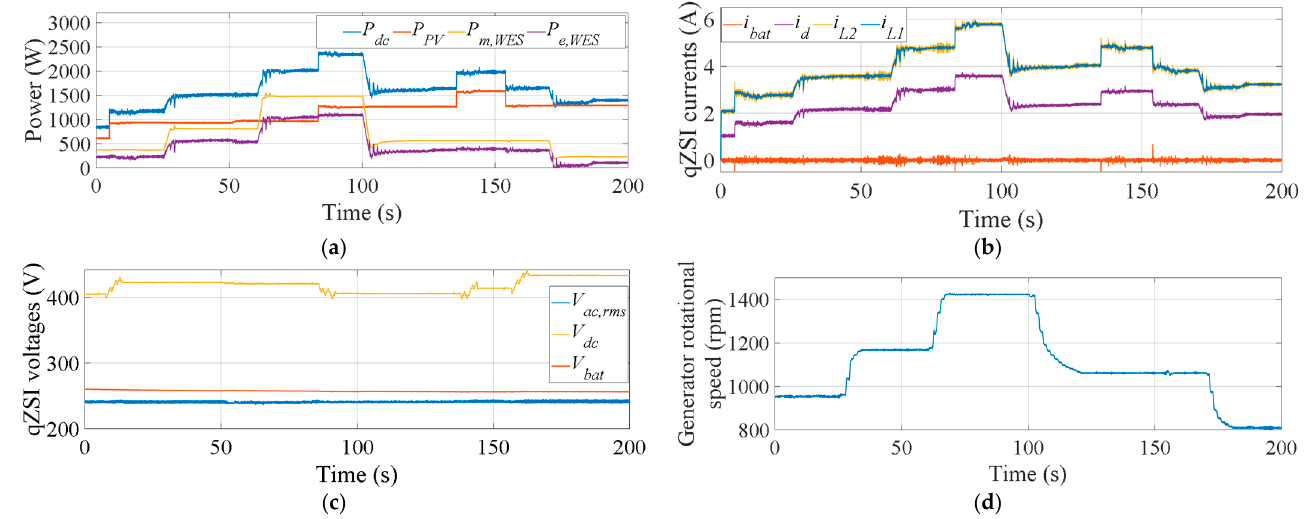
Figure 18. Dynamic responses during the grid-tie operation experiment: ( a ) electrical power and WT mechanical power; ( b ) qZSI currents; ( c ) qZSI voltages; ( d ) generator rotational speed.